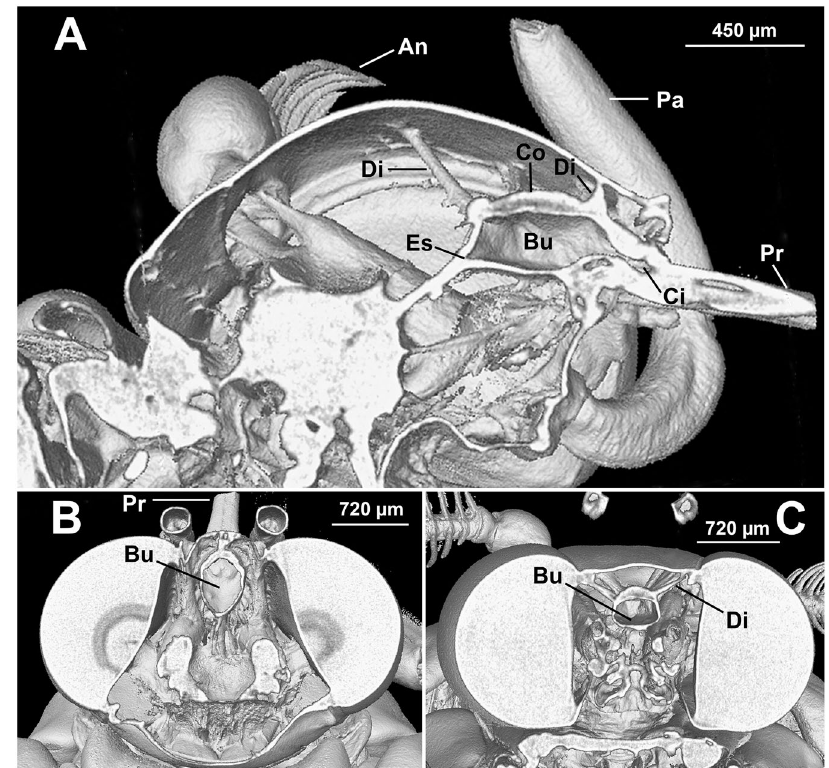
Figure 1. Micro-CT images of Nadata gibosa , showing relative position of the sucking pump in the head. ( A ) Lateral view. ( B ) Dorsal view. ( C ) Anterior view. An, antenna; Bu, buccal chamber; Ci, cibarium; Co, compressor; Di, dilator muscles; Es, esophagus; Pa, labial palp; Pr,